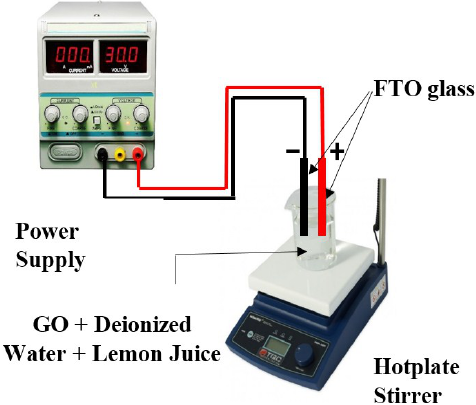
Figure 2. Experimental setup of electrochemical-reduction method.